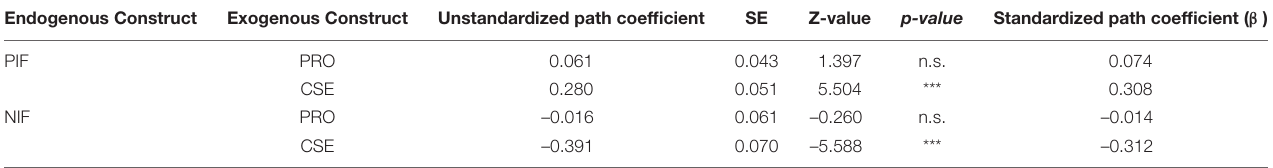
TABLE 6 | Structural model